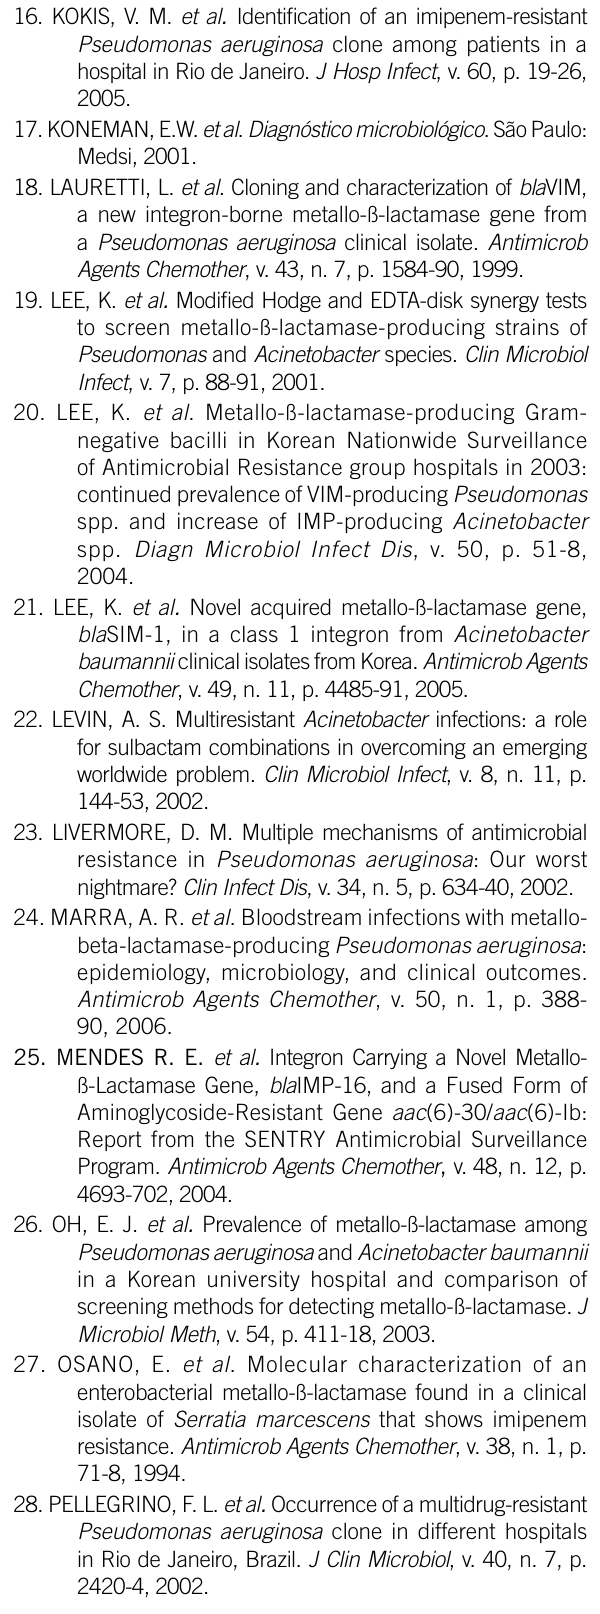
FIGUEIREDO, D. Q. et al . Detecção de metalo-beta-lactamases em amostras hospitalares de Pseudomonas aeruginosa e Acinetobacter baumannii • J Bras Patol Med Lab